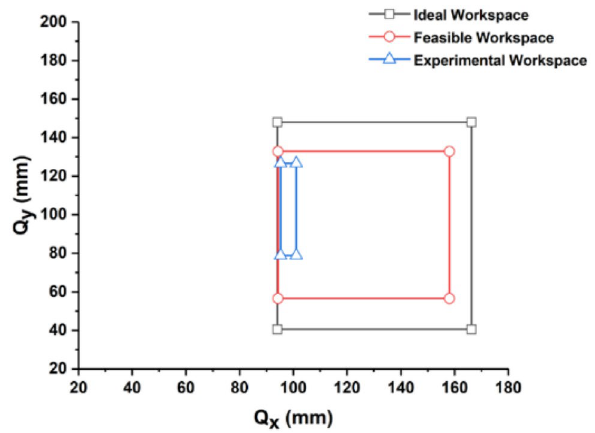
Fig. 18 Workspace Area of C9 Manipulator